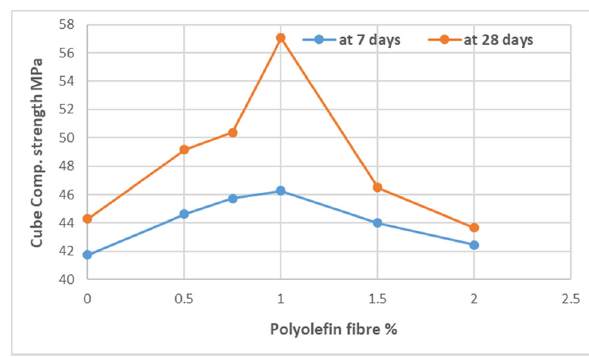
Figure 6: Compressive strength of concrete containing polyole fi n % in di ff erent mixes.